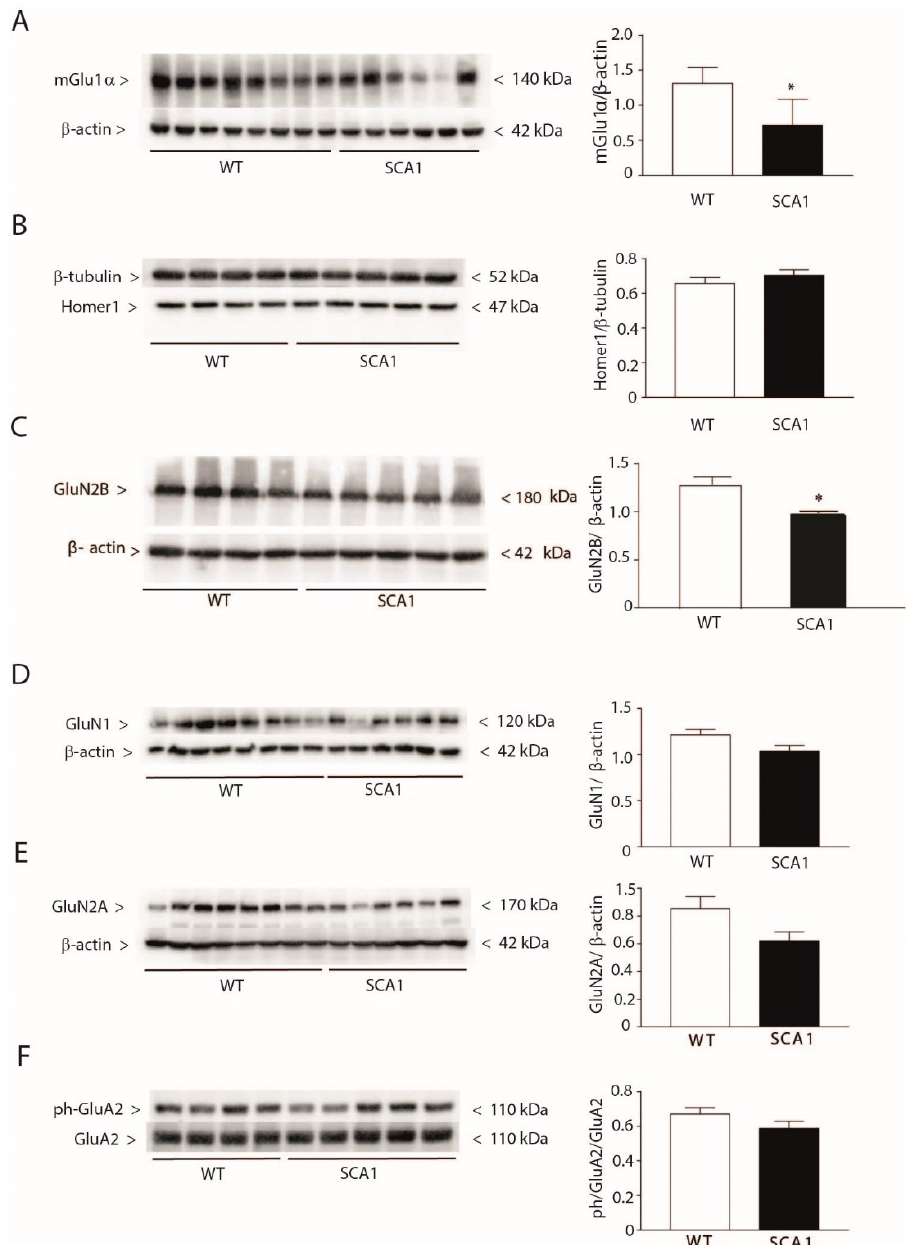
Figure 2. Reduced mGlu1 α and GluN2B protein levels in the hippocampus of 8-week-old SCA1 mice. Hippocampal protein levels of mGlu1 α receptors, pan-Homer1, GluN2B, GluN1 and GluN2A subunits of NMDA receptors, and phospho-GluA2 subunit of AMPA receptors of 8-week-old SCA1 mice and wild-type littermates are shown in ( A ), ( B ), ( C ), ( D ), ( E ), and ( F ), respectively. Values are means ± S.E.M. of 6–8 ( A ), 4–5 ( B,C,F ), and 6–8 ( D,E ) mice. * p < 0.05 vs. wild-type mice (Student’s t -test). In ( A ), t 12 = 3.709; in ( C ), t 7 =